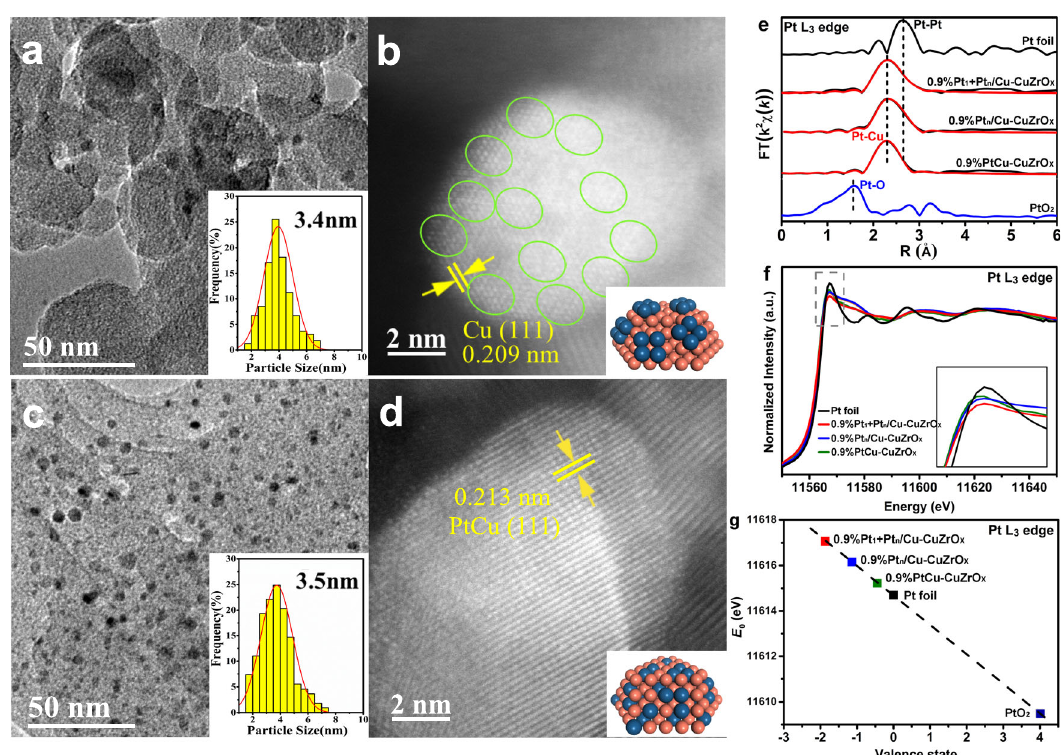
Fig. 3 | Modulation on Pt coordination con fi guration and electronic state. a – d Representative HRTEM and AC-HAADF-STEM images of 0.9%Pt n /Cu-CuZrO x ( a , b ) and 0.9%PtCu-CuZrO x ( c , d ). e – g Pt L3-edge FT-EXAFS spectra ( e ), normalized